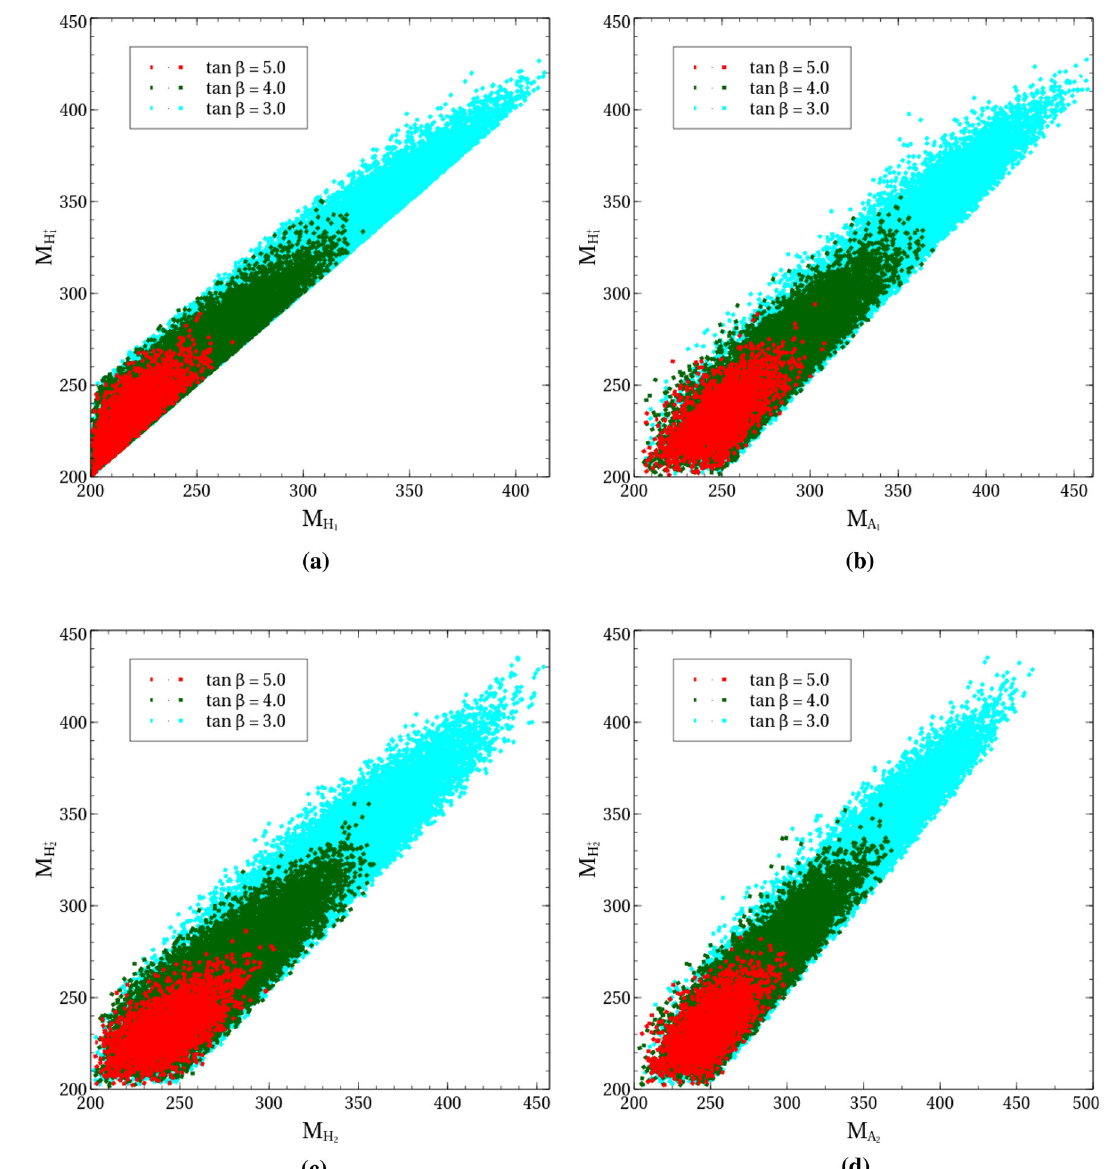
Fig. 4 This figure depicts parameter space in M vs . M H panel right). The cyan, green and red regions represent the parameter H + 1 1 space allowed by all constraints in the scalar sector (mentioned in Sect. plane (upper panel left), M vs . M A plane (upper panel right), H + 1 1 3) for tan β = 3 , 4 , 5 M vs . M H plane (lower panel left), M vs . M A plane (lower H + 2 H + 2 2 2